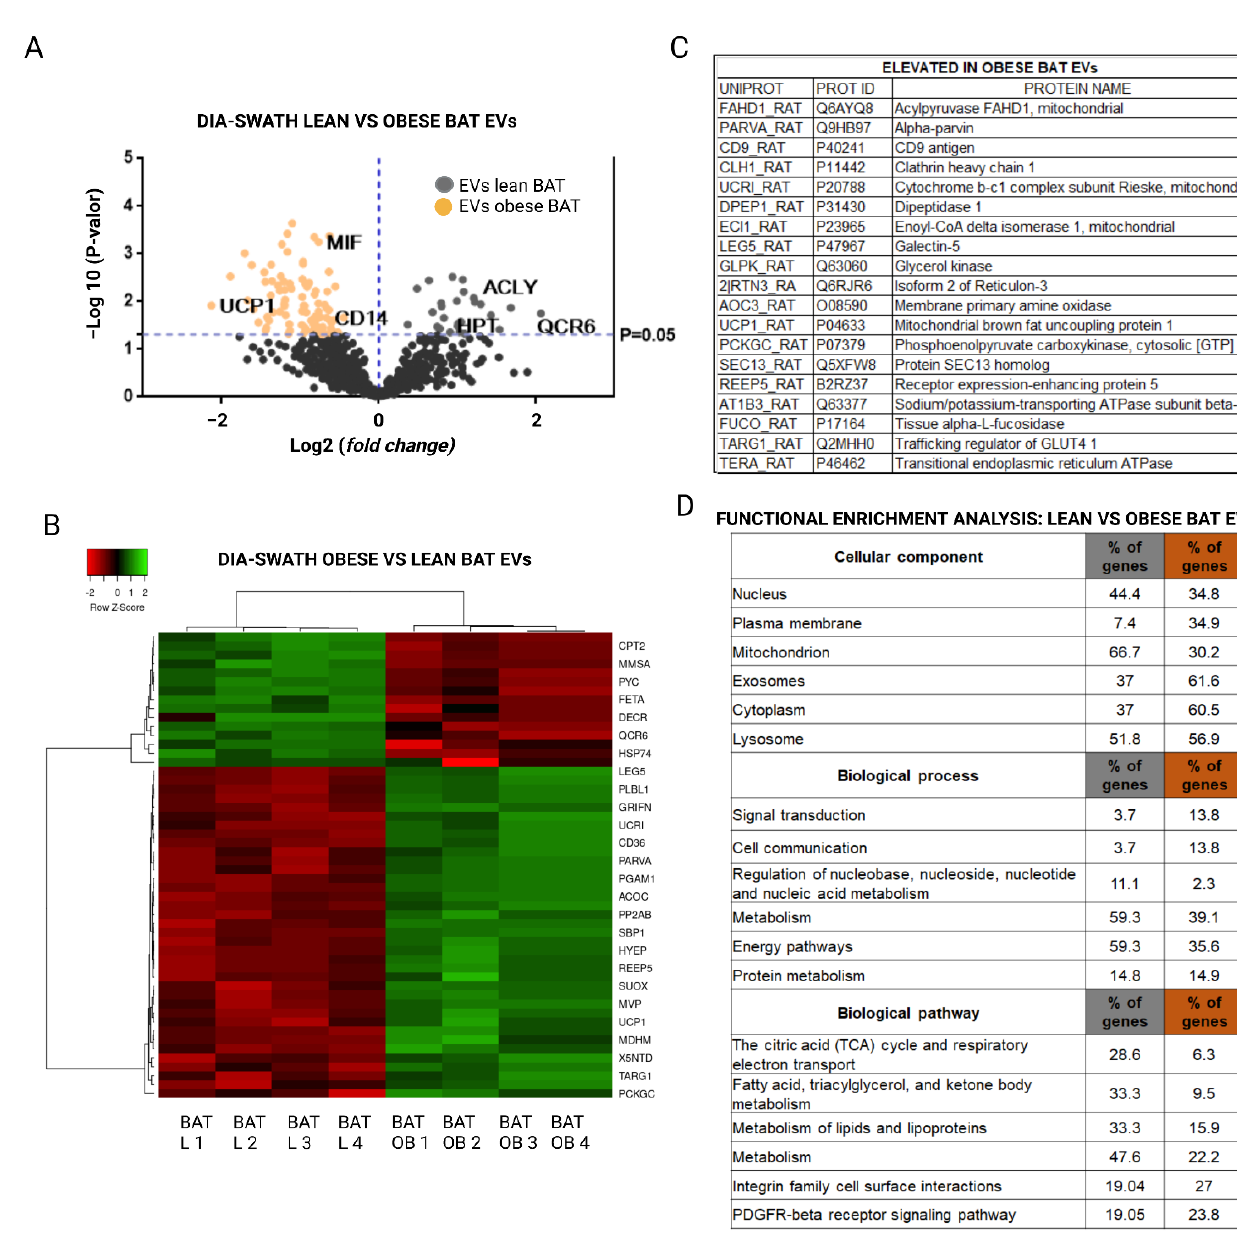
Figure 5. Quantitative DIA-SWATH/MS analysis of protein content in EVs secreted by brown adipose tissue (BAT) in normal (control) and obese animals. ( A ) A volcano plot representation of elevated proteins in BAT EVs from lean versus obese animals with a fold change >1.5; ( B ) cluster analysis by heat map representation of proteins in BAT EVs with a fold change ≥ 2 and p - values ≤ 0.05; ( C ) summary table with elevated proteins in EVs released from BAT of obese animals; ( D ) classification of the comparative functional enrichment (FunRich basis) according to cellular component, process, and biological pathway of the elevated proteins in BAT EVs from normal (grey) and obese (orange) animals.